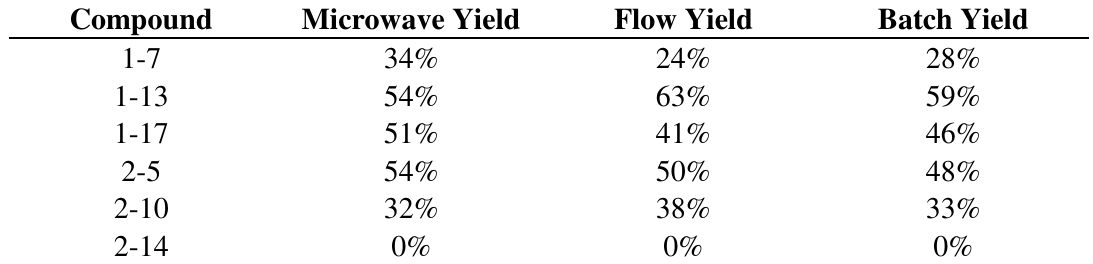
Table 3. Comparison between microwave and flow yields. Reactions were performed on 0.2 mmol scale. All yields are purified